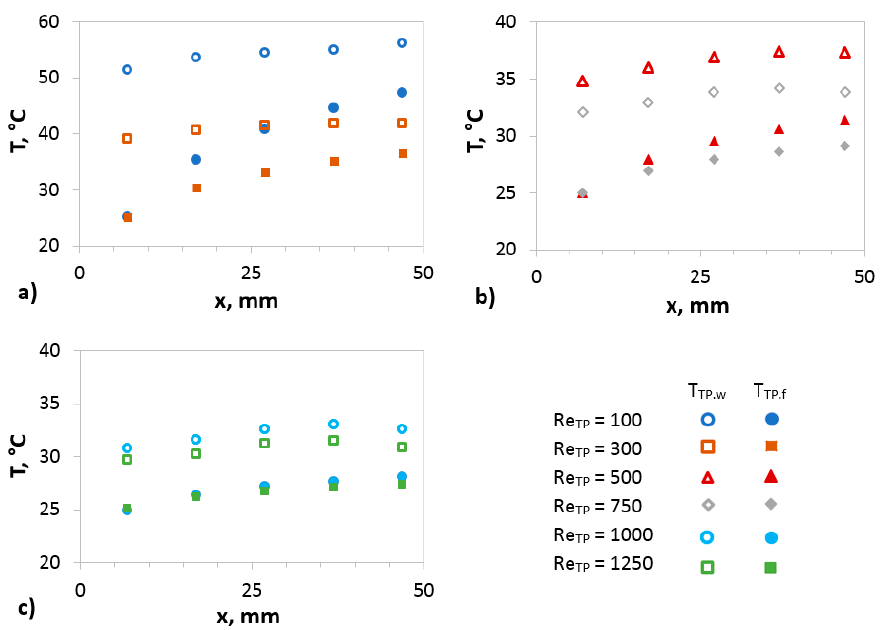
Figure 6. Dependence of wall temperature and fluid flow along the length of the MFHE channel for